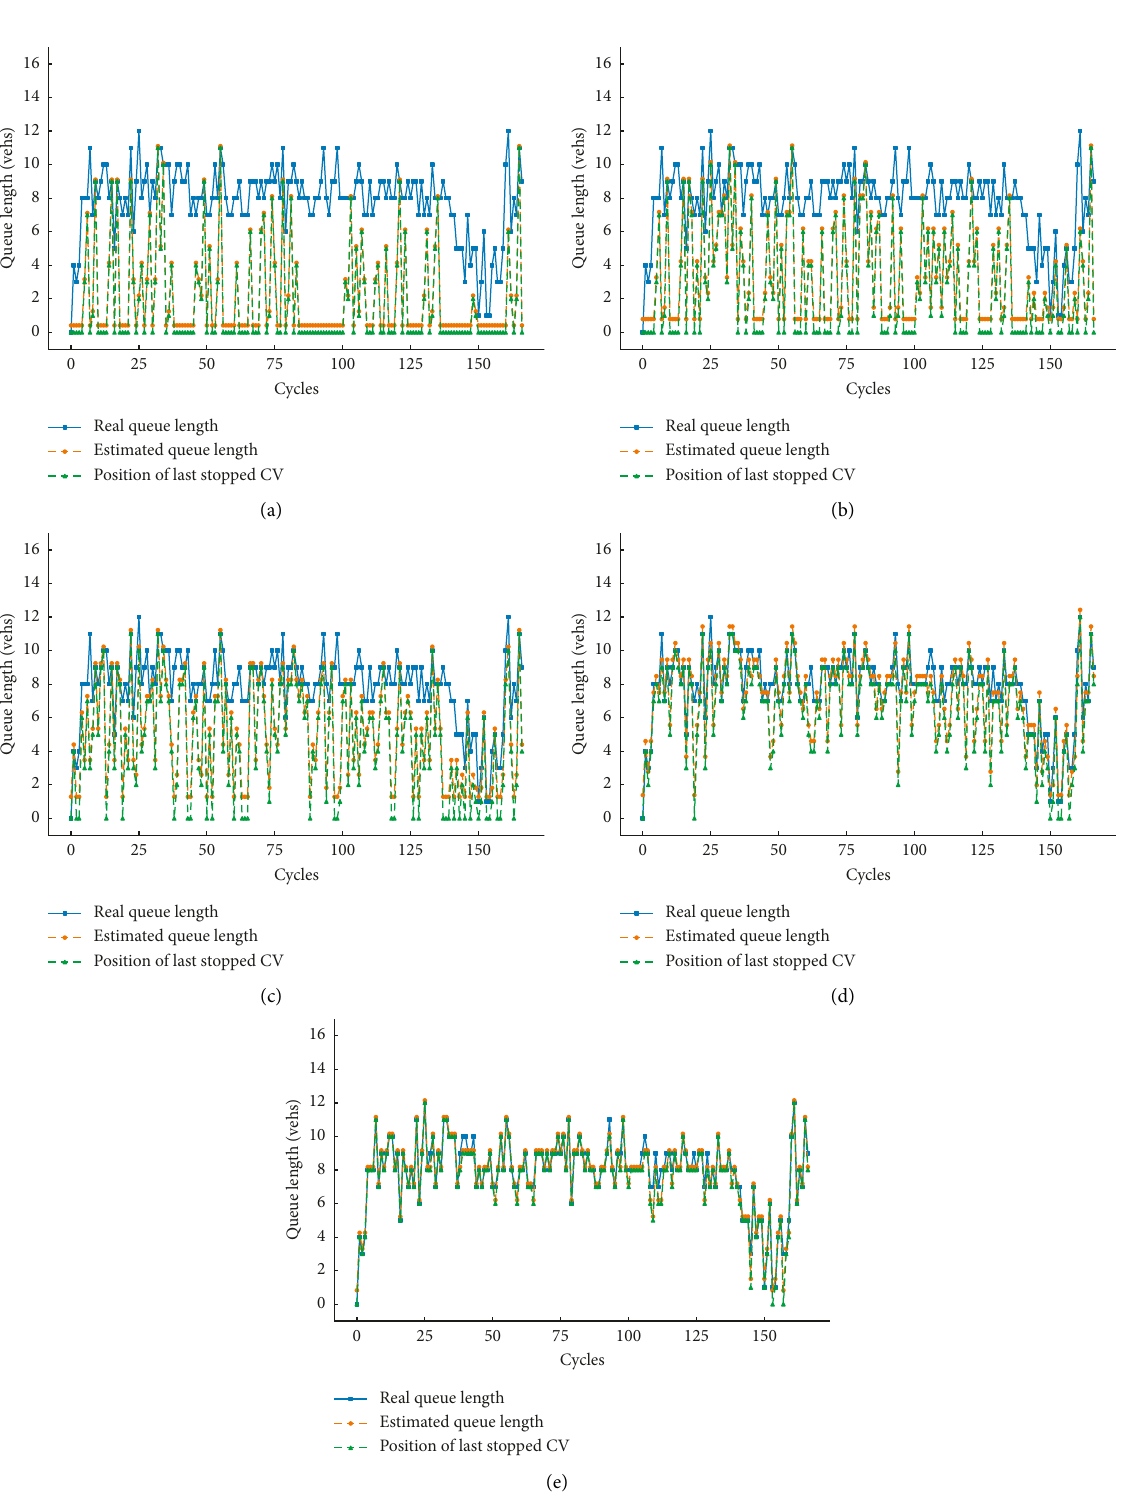
Figure 5: The estimated results with different CV penetration rates. (a) Penetration rate of 5%. (b) Penetration rate of 10%. (c) Penetration rate of 20%. (d) Penetration rate of 50%. (e) Penetration rate of Figure 5. For each plot, the blue solid line with star markers represents the ground truth queue length col- lected by queue counter set in VISSIM, the orange dotted line with dot markers represents the estimated queue